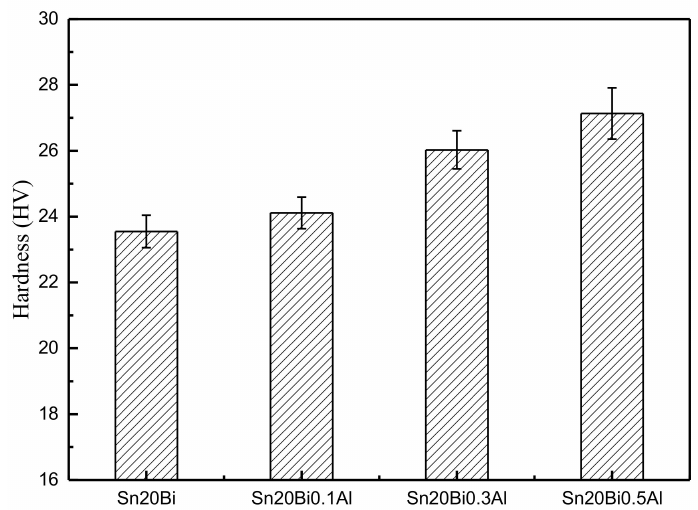
Figure 5. Micro-hardness of Sn-20Bi-xAl solder